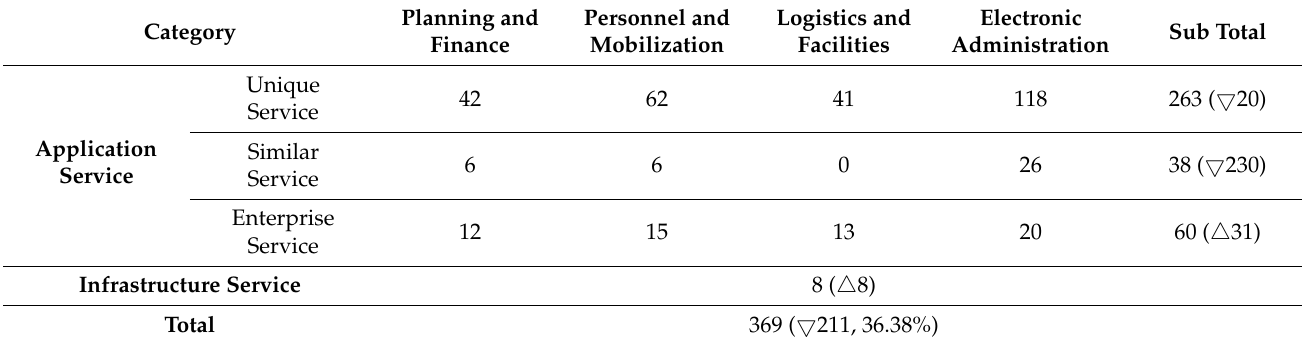
Table 3. Summary of the future military SaaS